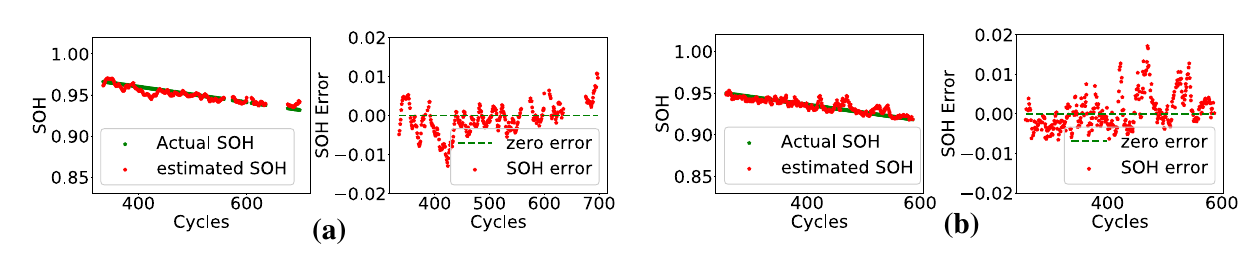
Figure 6. Plots of actual and estimated SOH, and error for on-device testing. ( a ) S2-B1, ( b )